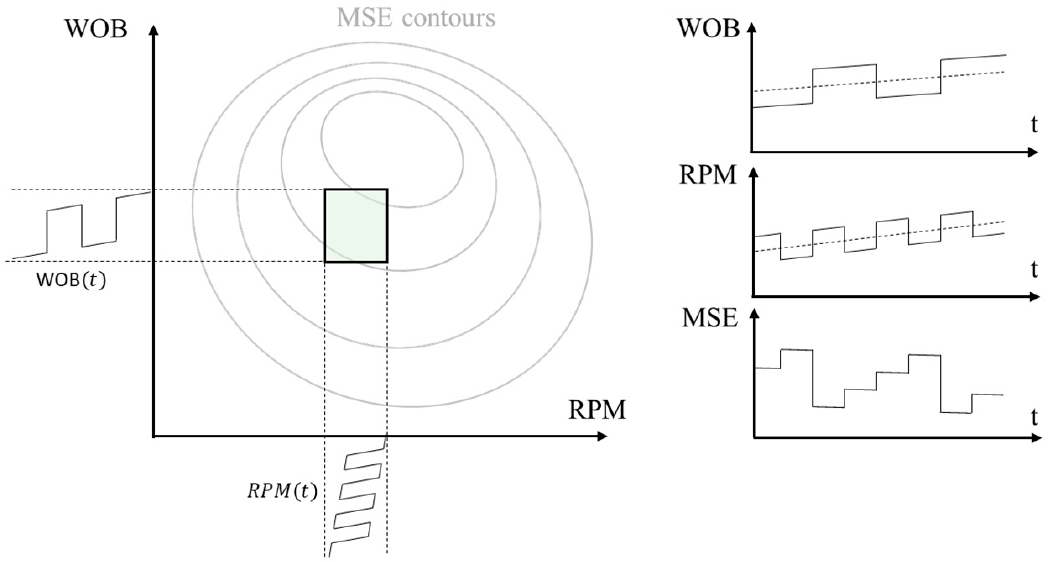
Figure 7. Concept illustration of multivariable ES applied to minimize the MSE.